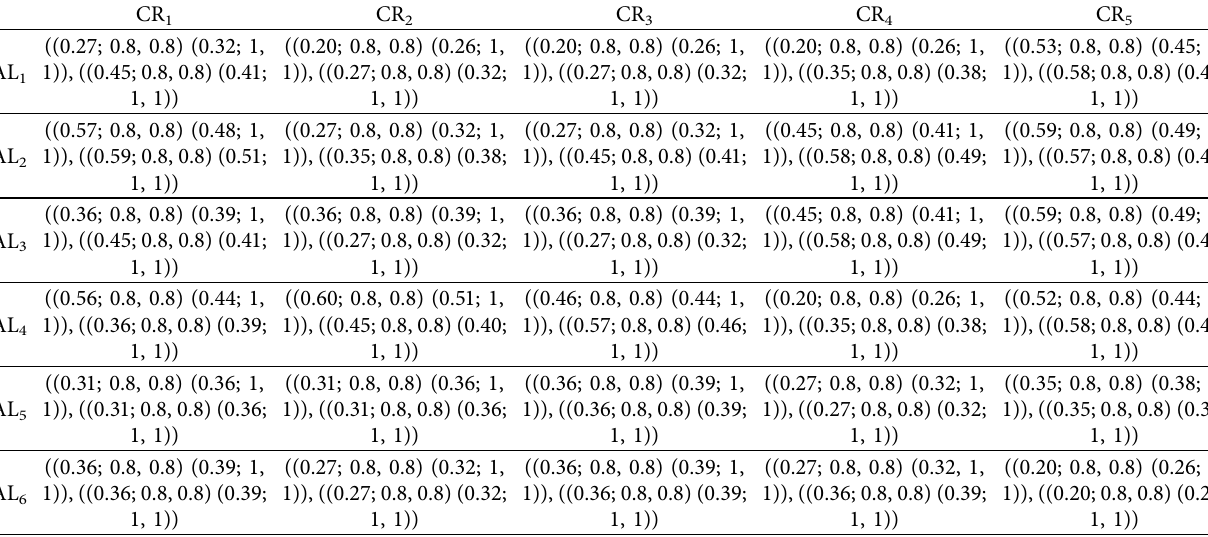
Table 5: Te IT2 fuzzy entropy.